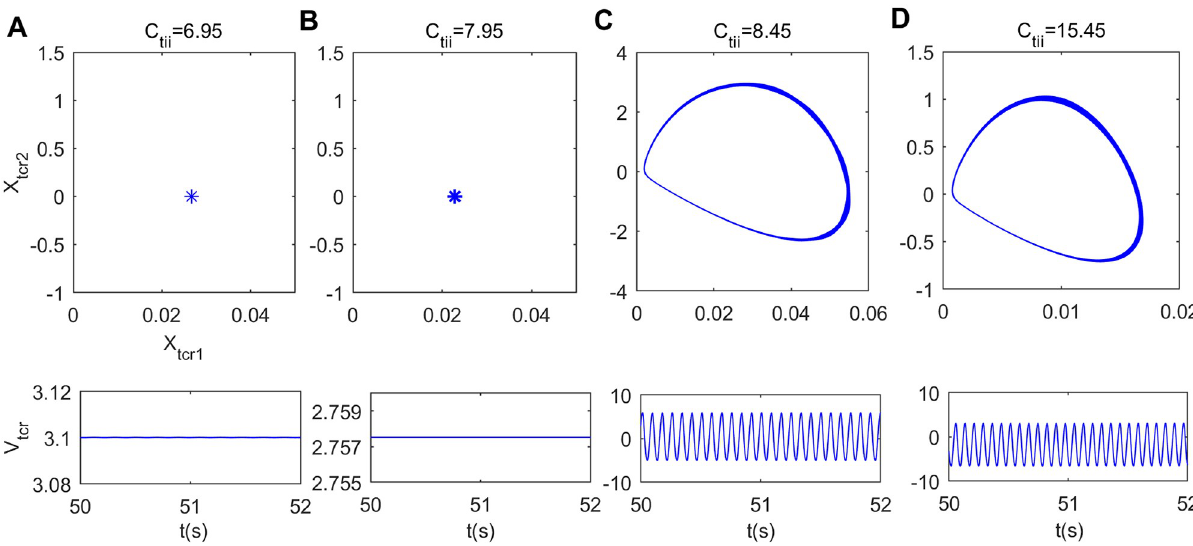
Fig 14. Phase plots (top panels) and the corresponding time series plots (bottom panels) of the thalamic module when C (A) C tii = 6.95, (B) C tii = 7.95, (C) C tii = 8.45, (D) C tii =